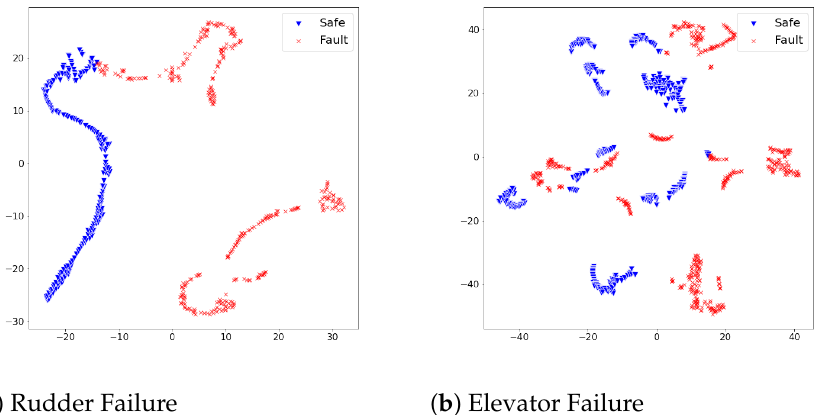
Figure 5. The distribution of dimensionality-reduced feature vectors from the safe states and faulty states vary on the 2D space. The different distribution of both states implies the set of used features effectively describes each state’s pattern. We analyzed how the lesser adjoined distribution between safe states and faulty states contributed to precise fault detection performance.